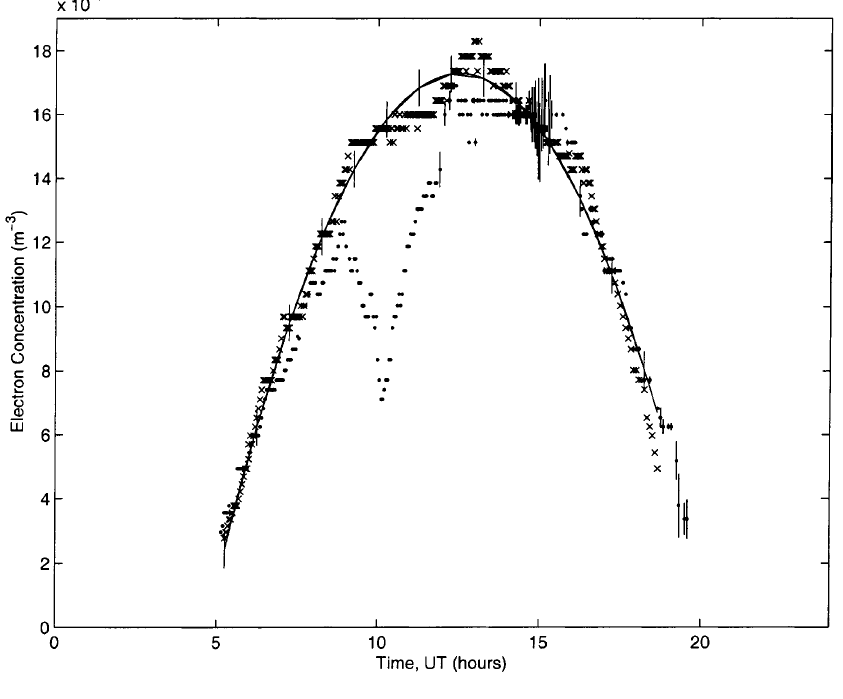
Fig. 2. Electron concentration measure- ments for 11 August ( dots ), 10 August, 1999 ( crosses ), and a polynomial fit to the data from 10 August, 1999 ( solid line ). The ‘‘control day’’ is obtained from the fitted polynomial and scaled by a constant multiplying factor to give the best least- squares fit to the data, prior to first contact on 11 August. Note that the polynomial fit shown in this figure has not yet been scaled to fit the